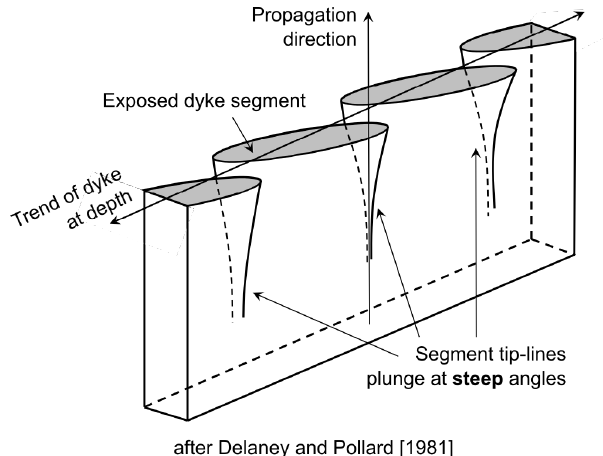
Figure 1: Schematic diagram of a vertical dyke propa- gating upwards and divided into en echelon segments, or ‘fringes’, at the leading edge (after Delaney and Pol- lard [1981]). Note that this model implies that the mar- gins of dyke segments at the segment tips are steeply